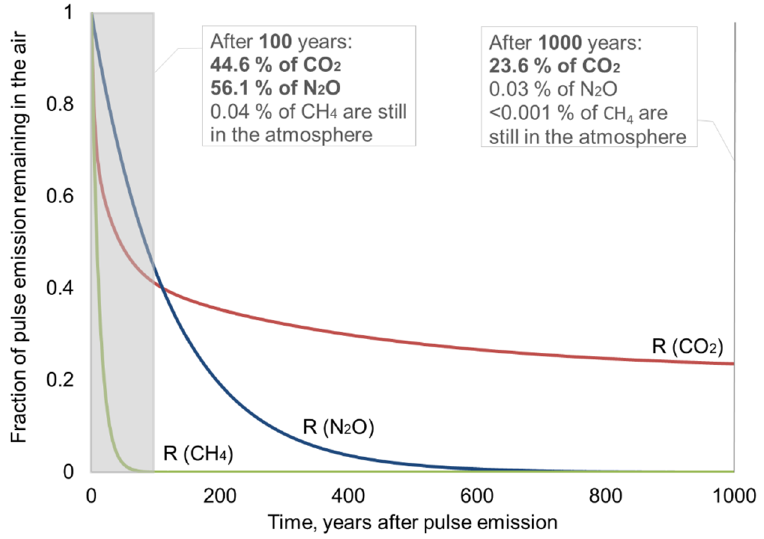
Figure 3. The fraction of pulse emissions at year zero remaining for greenhouse gas emissions of CO 2 , N 2 O, and CH 4 in 1000 years’ time frame. N 2 O, and CH 4 in 1000 years’ time frame. Energies 2020 , 13 , x FOR PEER REVIEW